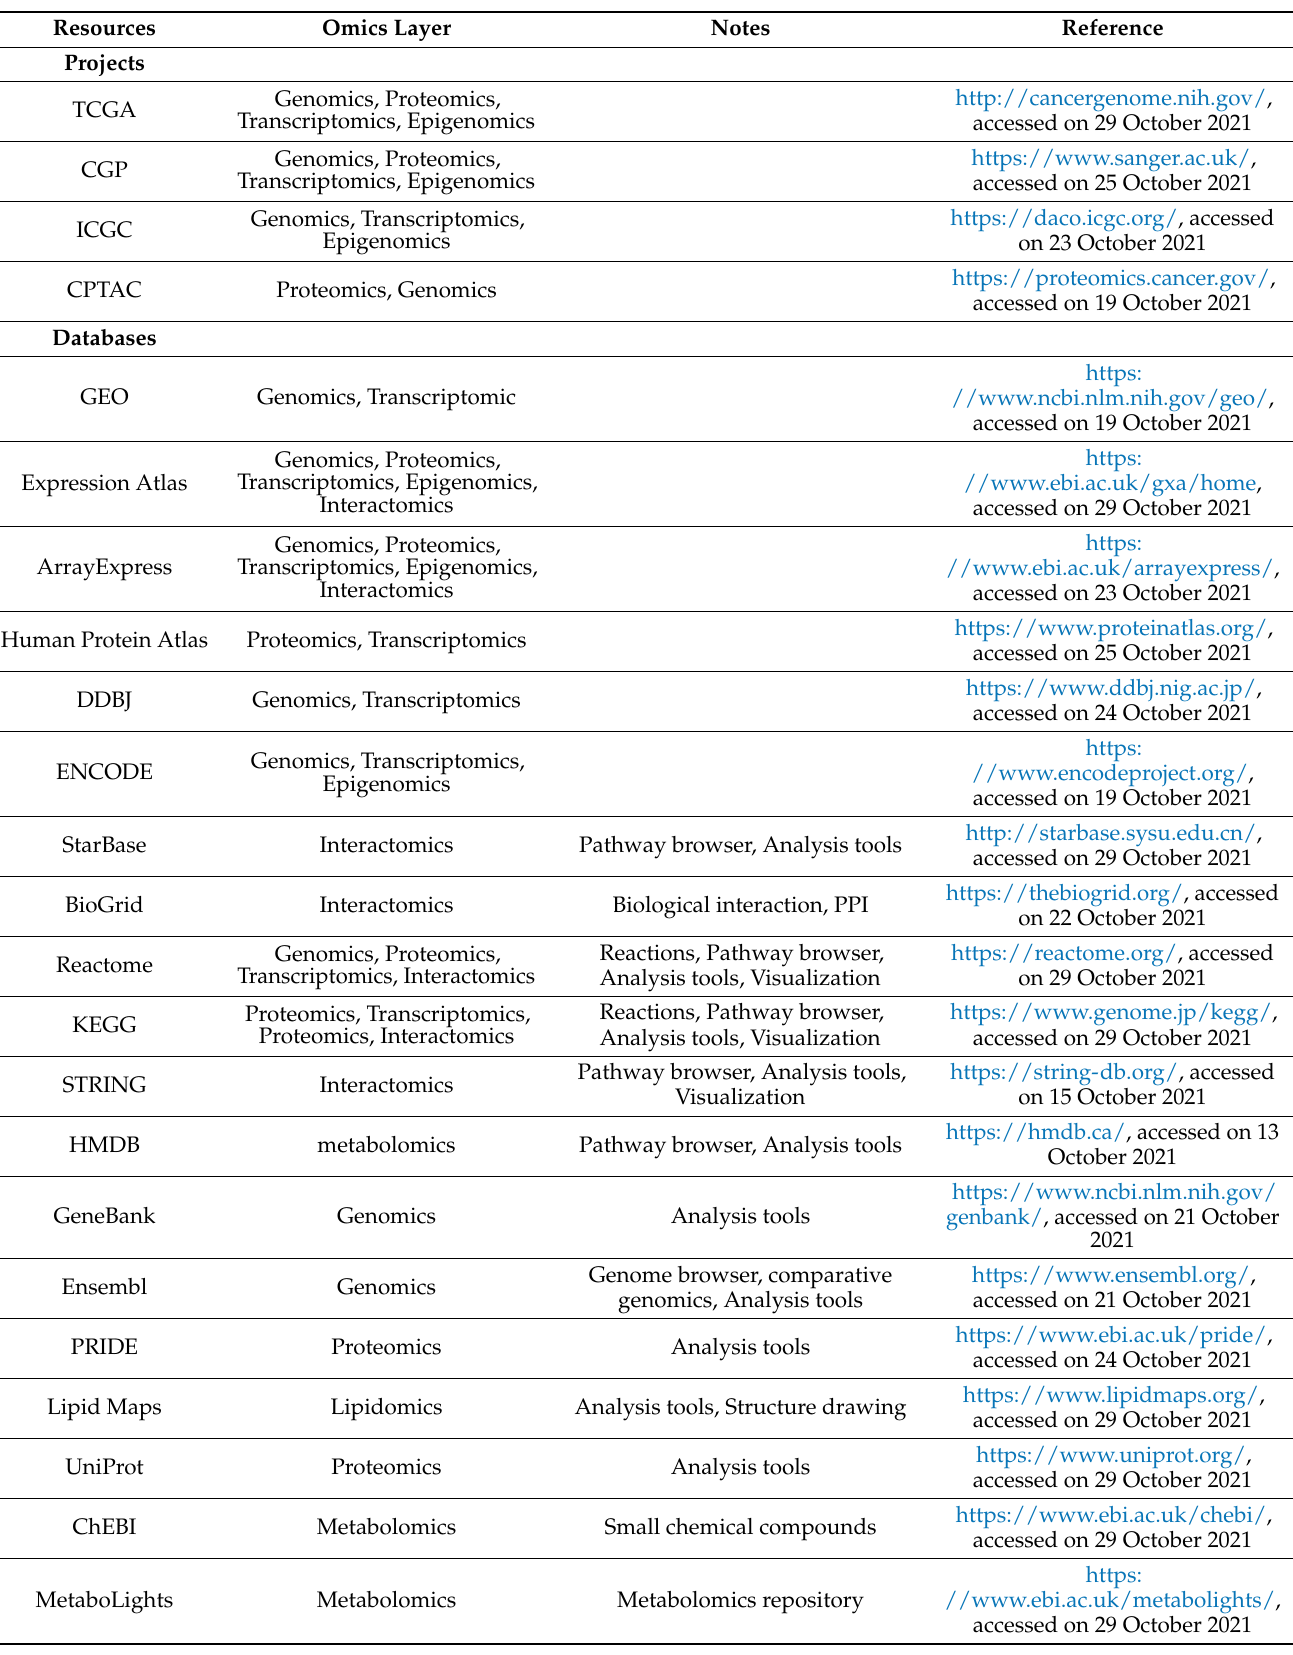
Table 1. Omics sources for